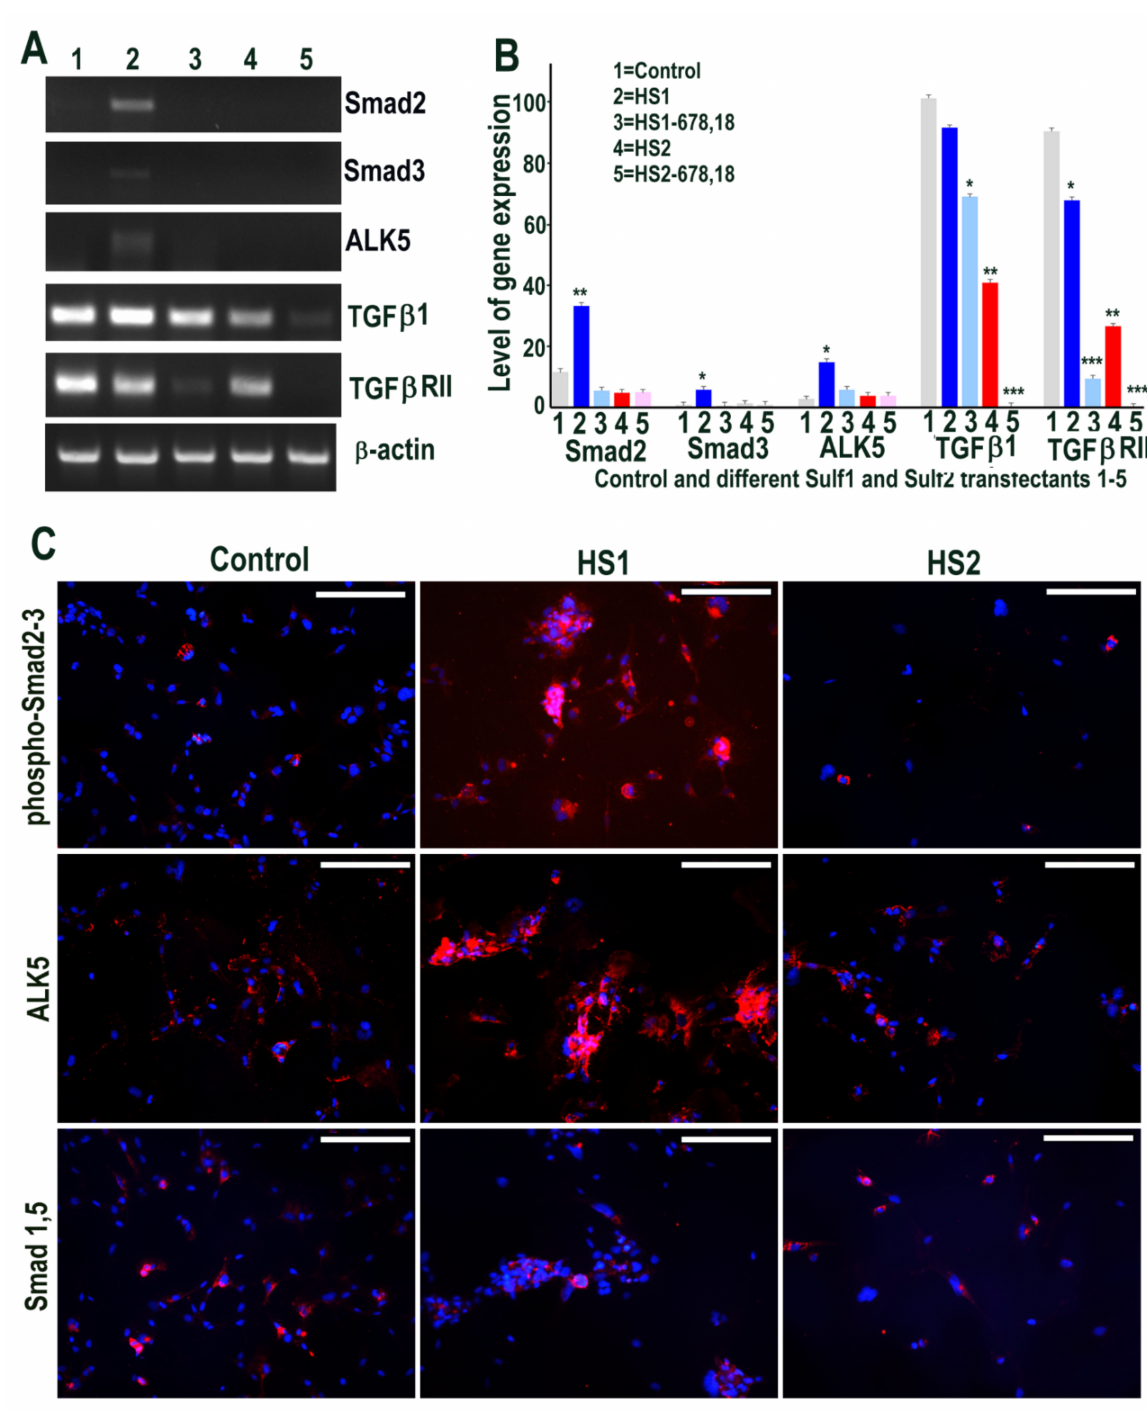
Figure 2. ( A , B ) Selective changes in levels of TGF β cell signalling following transfections of HMec1 cells with (1) pcDNA3, (2) full length Sulf1 (HS1), (3) shorter inactive Sulf1 (HS1-678,18), (4) full length Sulf2 (HS2) and shorter inactive Sulf2 (HS2-678,18) examined by RT PCR analysis and quantified using Image J analysis. Error bars = means ± SD; *** p < 0.0001; ** p < 0.001; * p < 0.01. ( C ) Changes in TGF β cell signalling following transfections were also confirmed by immunostaining for phosphoSmad2/3 and ALK5 as well as very low level detection with no apparent changes in BMP signalling using antibody to Smad1/5 that also confirmed virtually no expression using RT PCR procedure (not shown). Scale bar = 100 µ